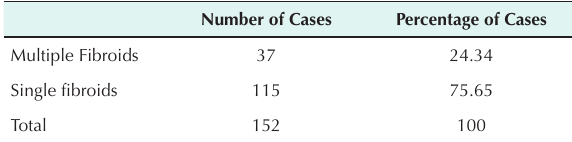
Figure 5. Histopathological Findings of the Fallopian Tube. Figure Table 3. Incidence of Fibroids